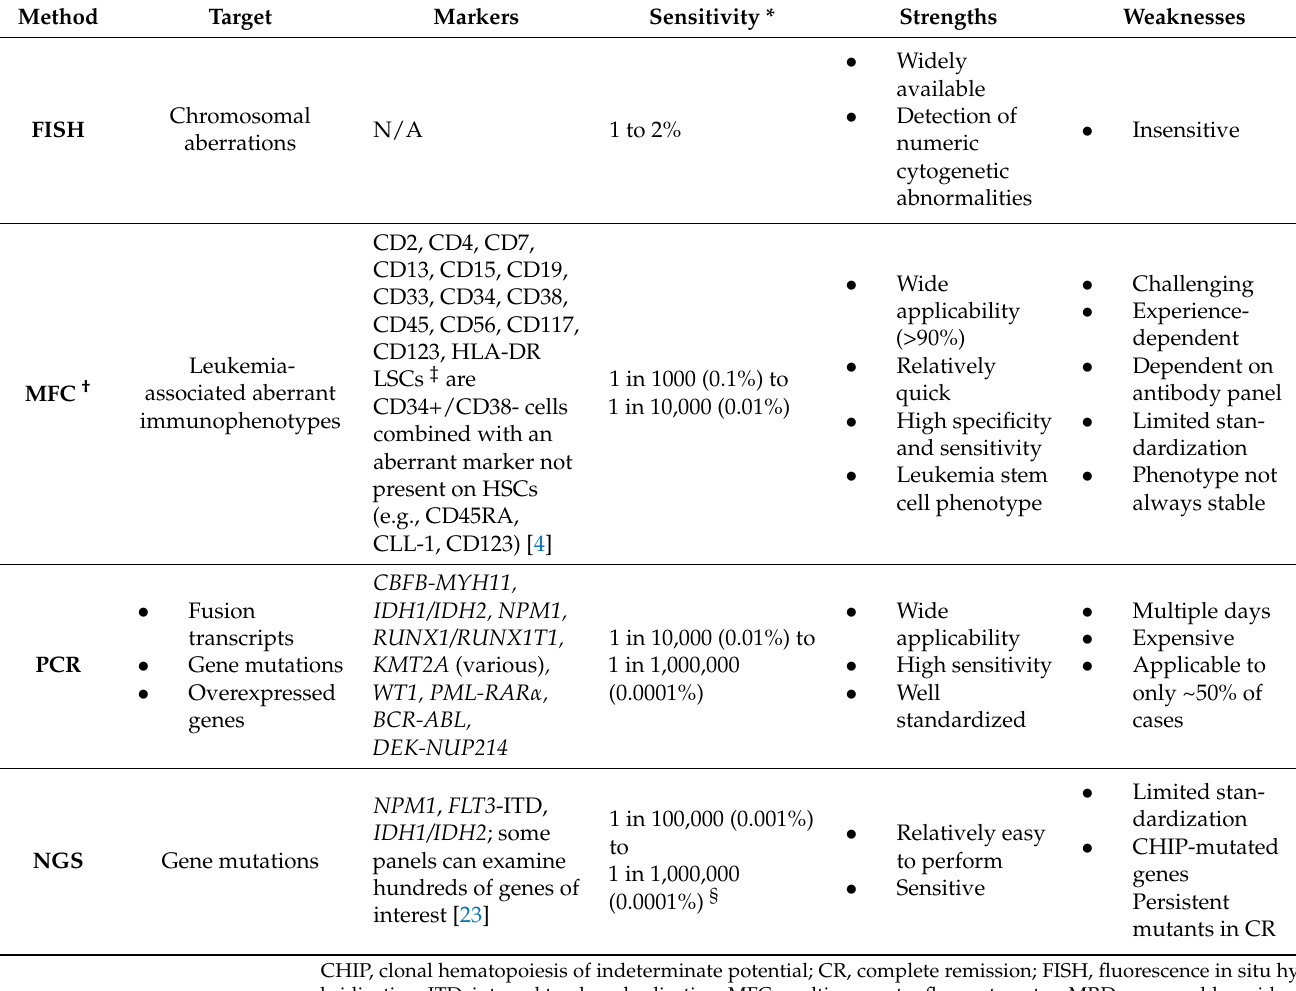
Table 1. Methods of MRD detection